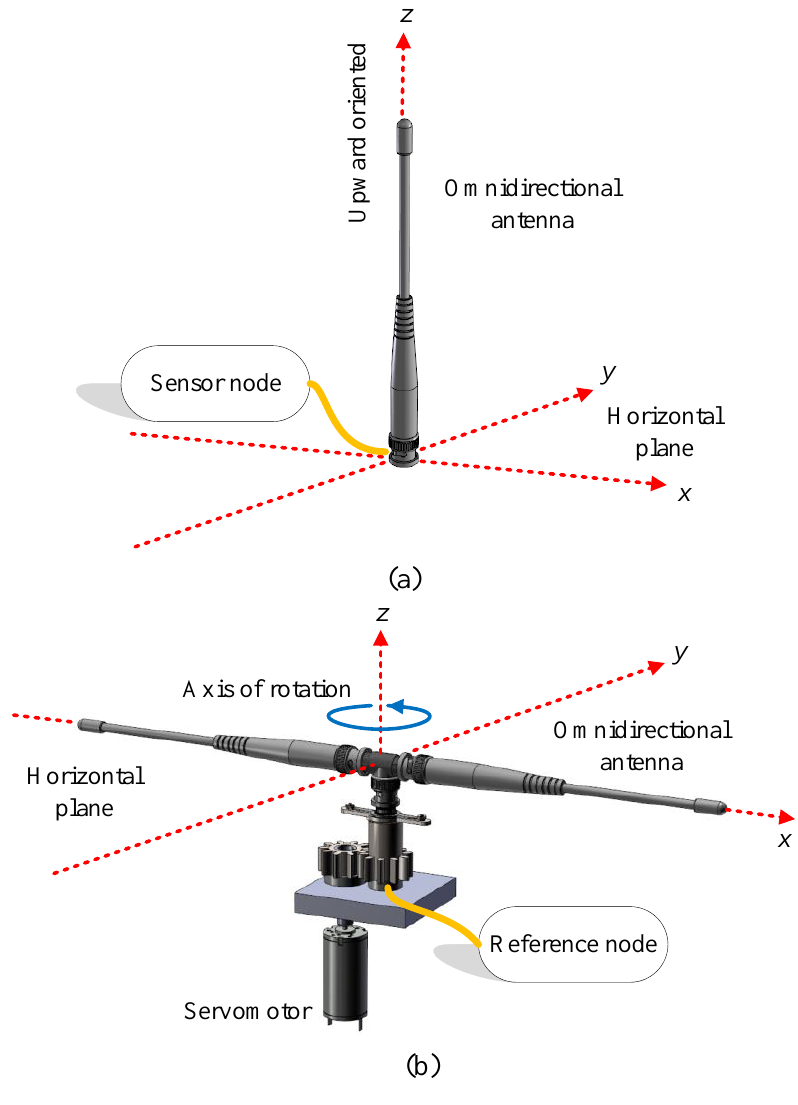
Figure 2. Schematic diagrams of the configurations used to couple external antennas and other peripheral circuits with (a) a sensor node and (b) a reference